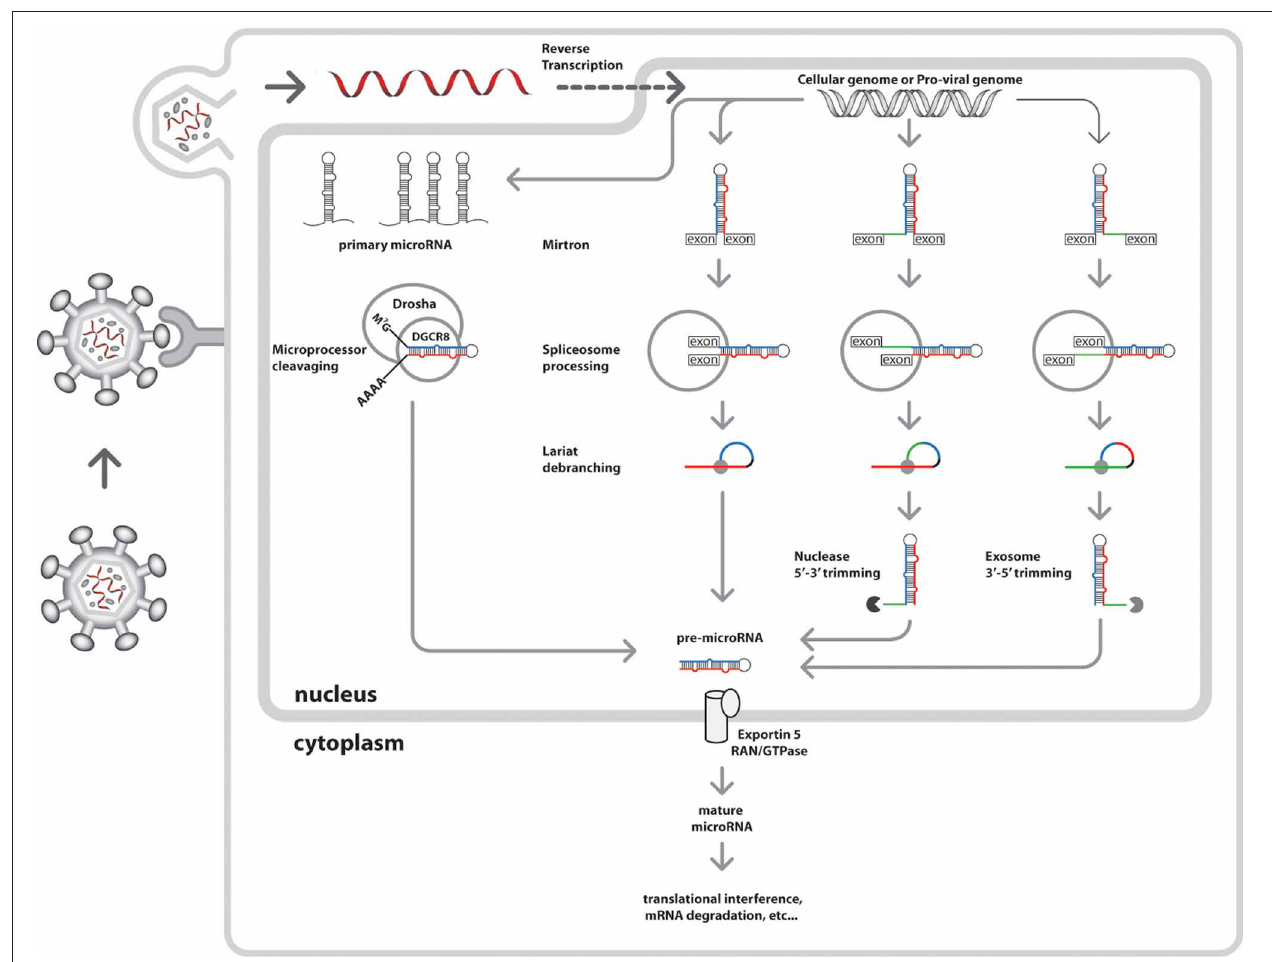
FIGURE 2 | Nuclear events of the integrated cellular and HIV-1 microRNA biogenic pathways. The nucleus of the host cell is the central site of both cellular and viral microRNA biogenesis. Initially, HIV-1 virion particles attach to host cells via CD4 receptors signaling viral attack. This would be followed by HIV-1 particle fusion with the cell membrane and uncoating to load its RNA genome into the cytoplasm. The viral replicase enzyme facilitates production of more RNA genome later to be shuttled into the nucleus for viral transcription and integration into cellular genome.HIV-1 microRNA biogenesis is synchronousto cellular microRNA production in the host cell nucleus where other microRNA biogenic enzymes are present. Independent nuclear events of miRNA biogenesis have several modes of pre-microRNA generation (viral and cellular), initially from primary microRNA transcribed by either RNA polymerase II or III. he canonical pathway is undertaken by intergenic microRNAs resulting from microprocessor cleavage (Drosha and DGCR8) of